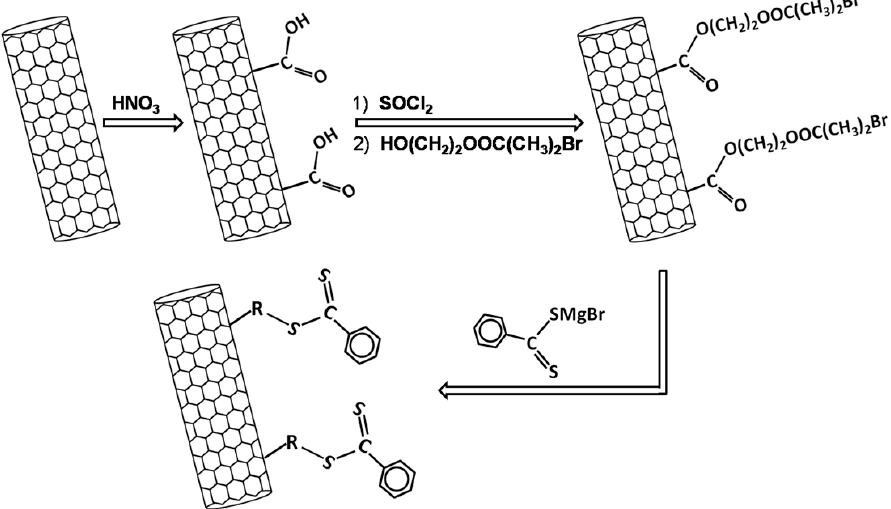
Figure 1. Schematic showing the steps used by Cui et al . to synthesize nanotube-attached RAFT